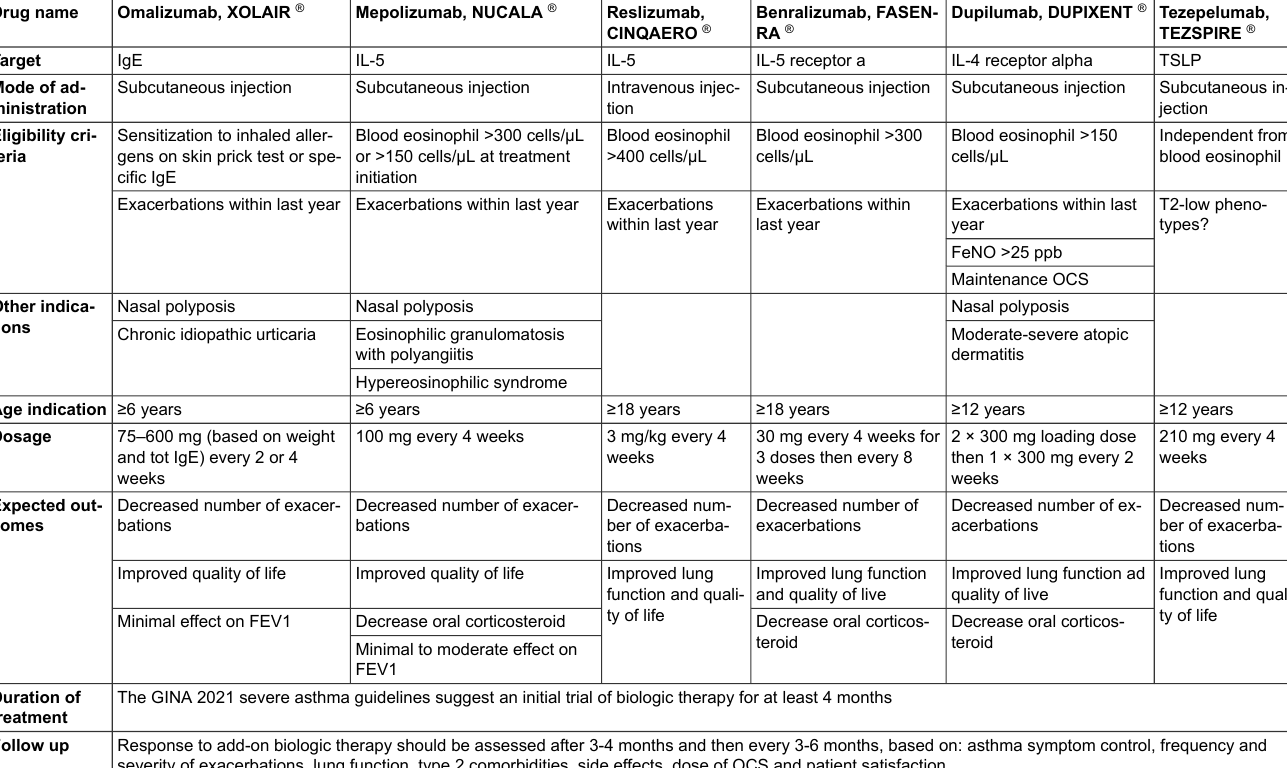
Table 2: Main characteristics and effects of existing biologic therapies against severe asthma based on Global Initiative for Asthma 2021 [7] and Swissmedic recommendations. Drug